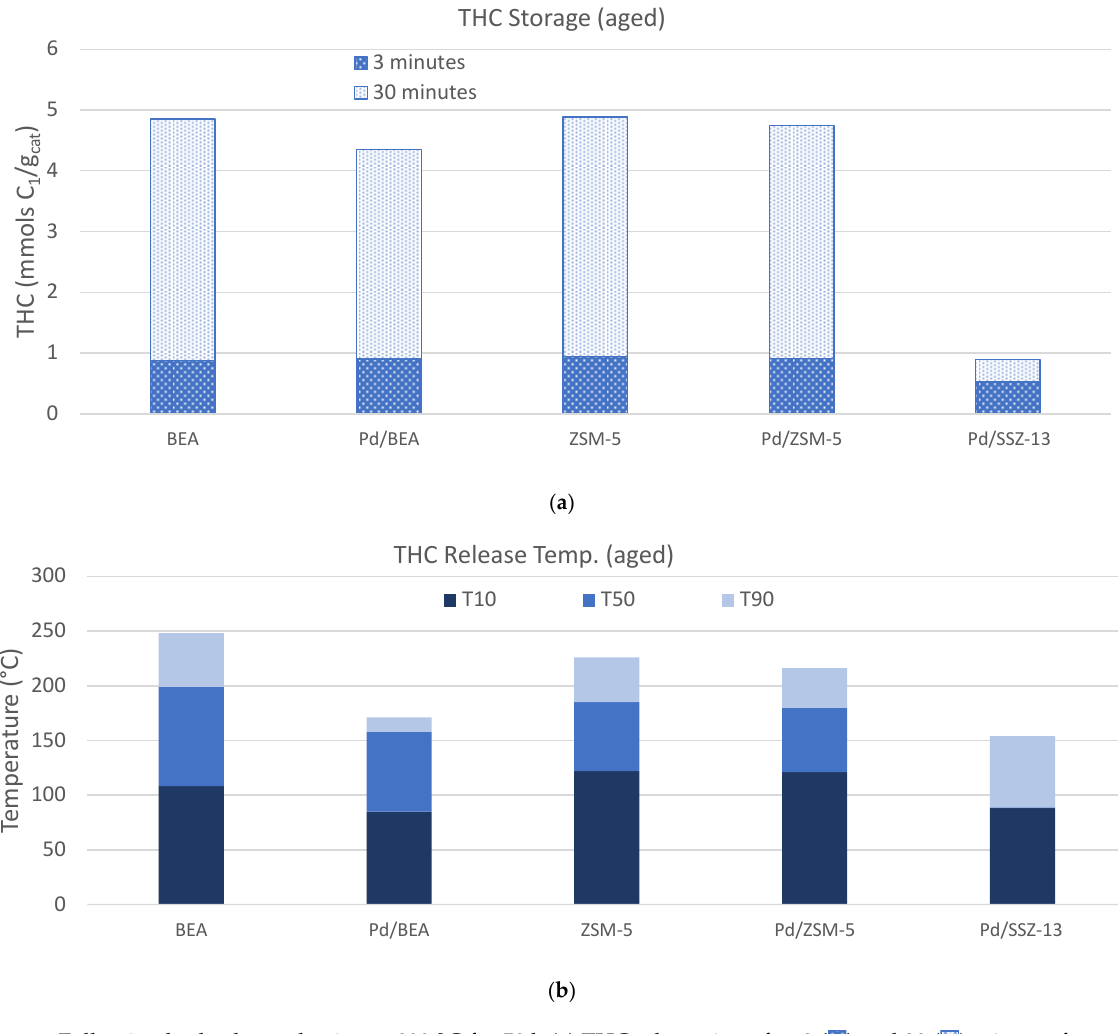
Figure 5. ( a ) NOx adsorption after 3 ( ) and 30 ( ) minutes for each of the materials studied. ( b ) The temperature where 10% (T10, ■ ), 50% (T50, ■ ), or 90% (T90, ■ ) of the NOx is released. Table 2. NOx storage values (mmol/g cat ) for ion-exchanged zeolites during lean trapping evaluation after 3 and 30 min. The total amount of observed NOx released during the first 15 min of the ramp, and the temperature where 10% (T10), 50% (T50), or 90% (T90) of NOx is released is also shown.